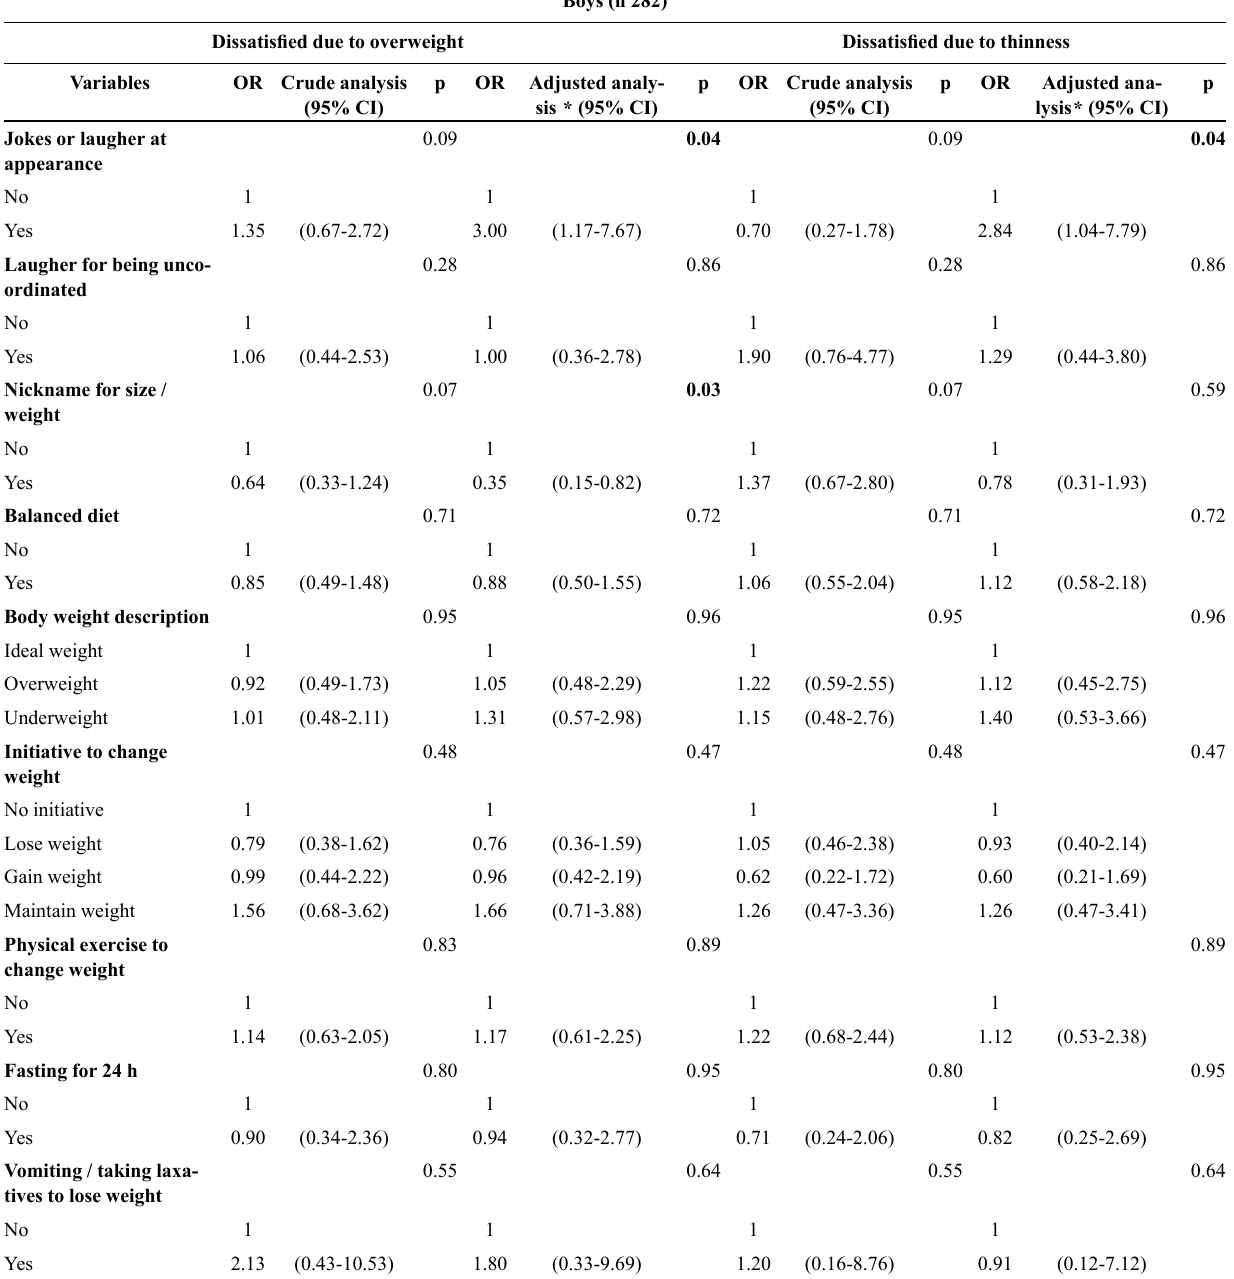
Table 2 - Crude and adjusted multinomial logistic regression analysis between body image and behaviors and attitudes for weight control in boys from the municipality of Criciúma, Santa Catarina,